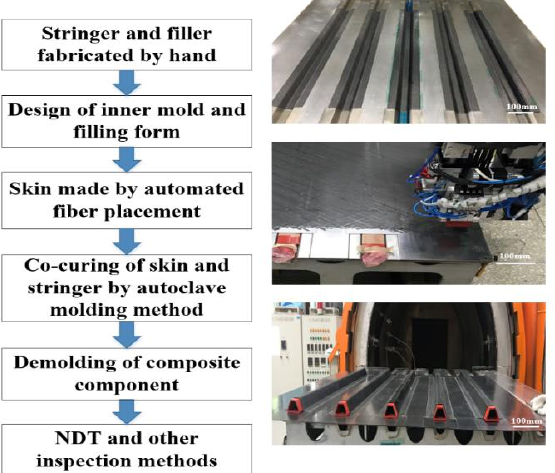
Figure 1. Manufacturing process of stringer-stiffened panel.